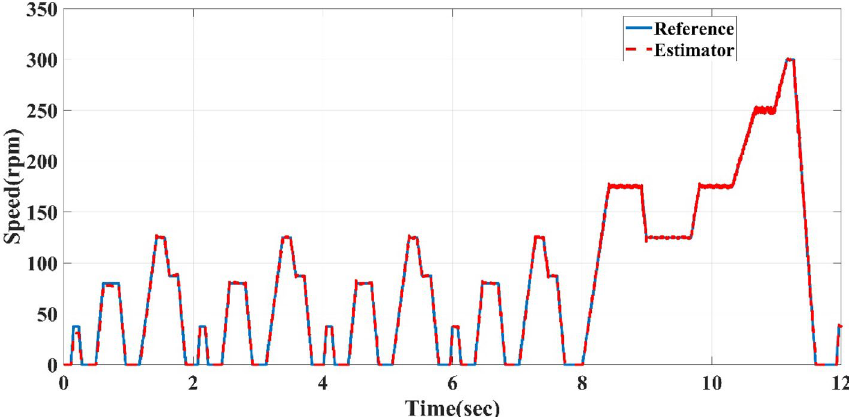
Figure 13. Reference NEDC speed cycle and straight-line guided by reference speed sensorless estimator of AFPMSM.